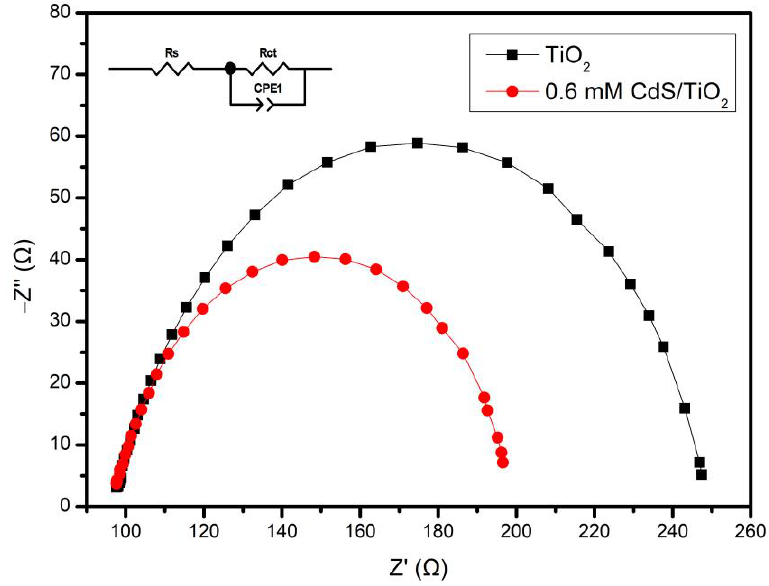
Figure 4. EIS of TiO 2 and CdS/TiO 2 NTs.